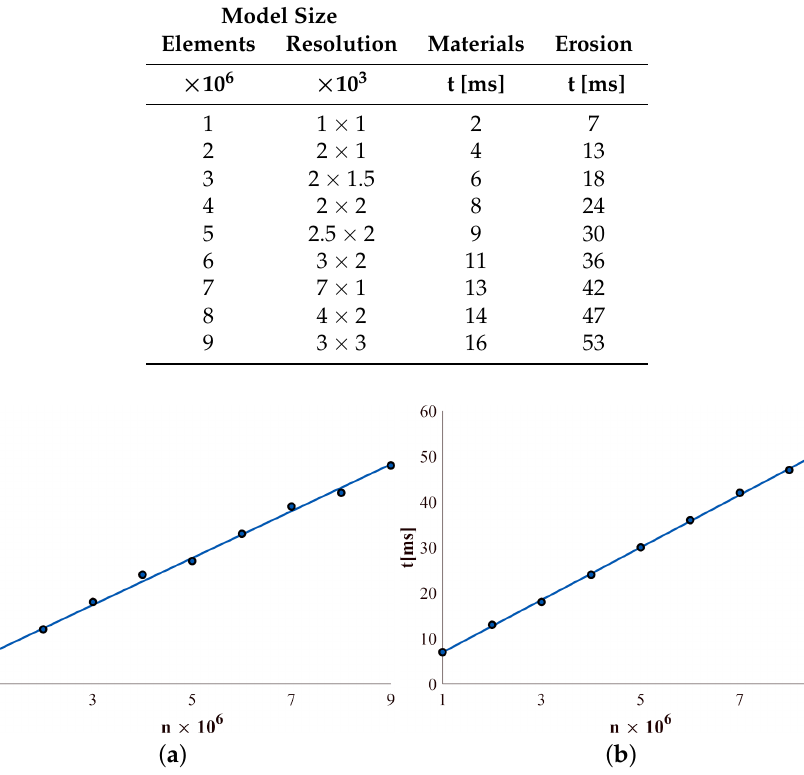
Table 3. Computational efficiency of the proposed techniques depending on the model size.